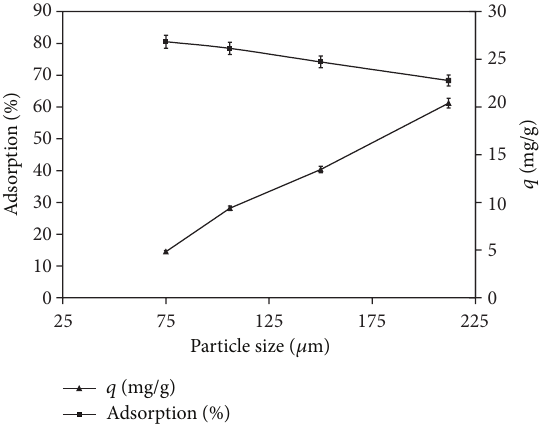
Figure 4: Effect of Ficus benghalensis L. particle size on biosorption of lead for 20 mg/L of metal, 0.1g/30 mL of biosorbent concentra- tion, and solution pH of